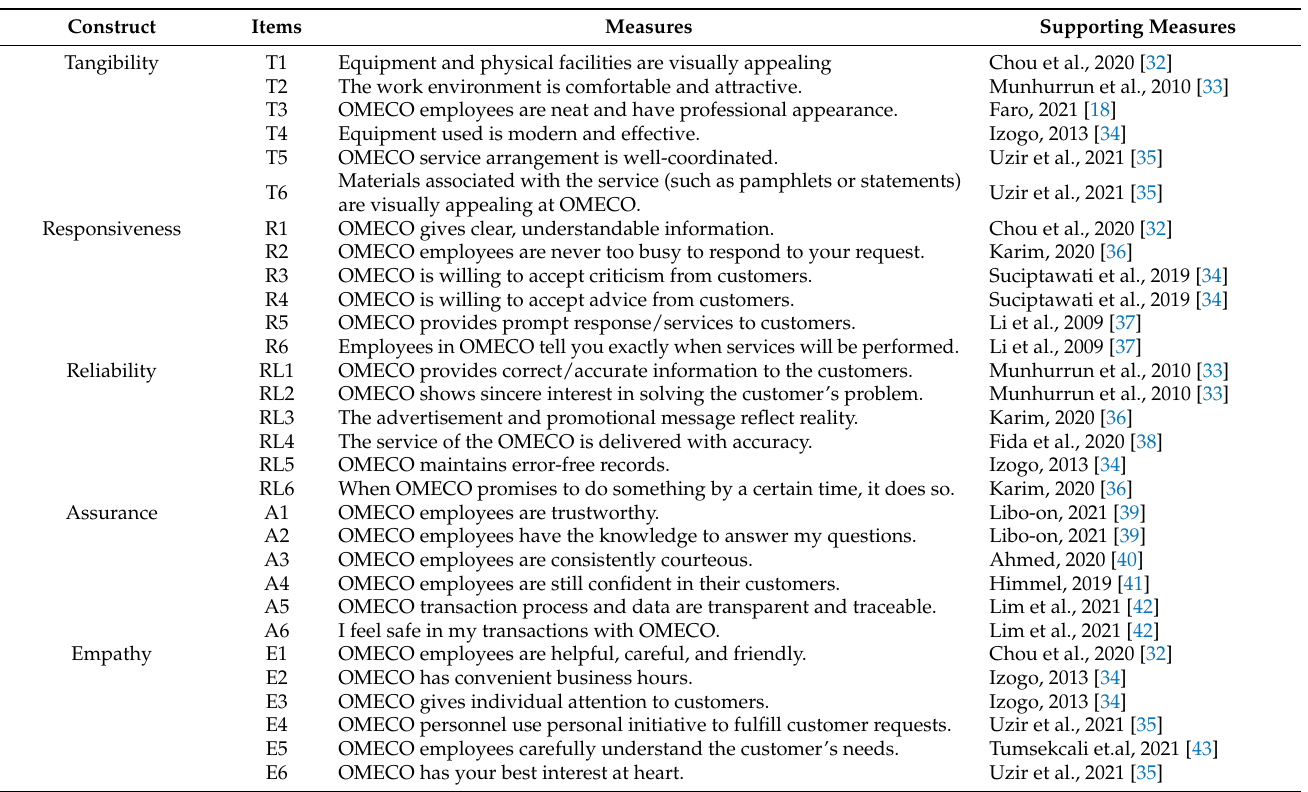
Table 2. The constructs and measurement